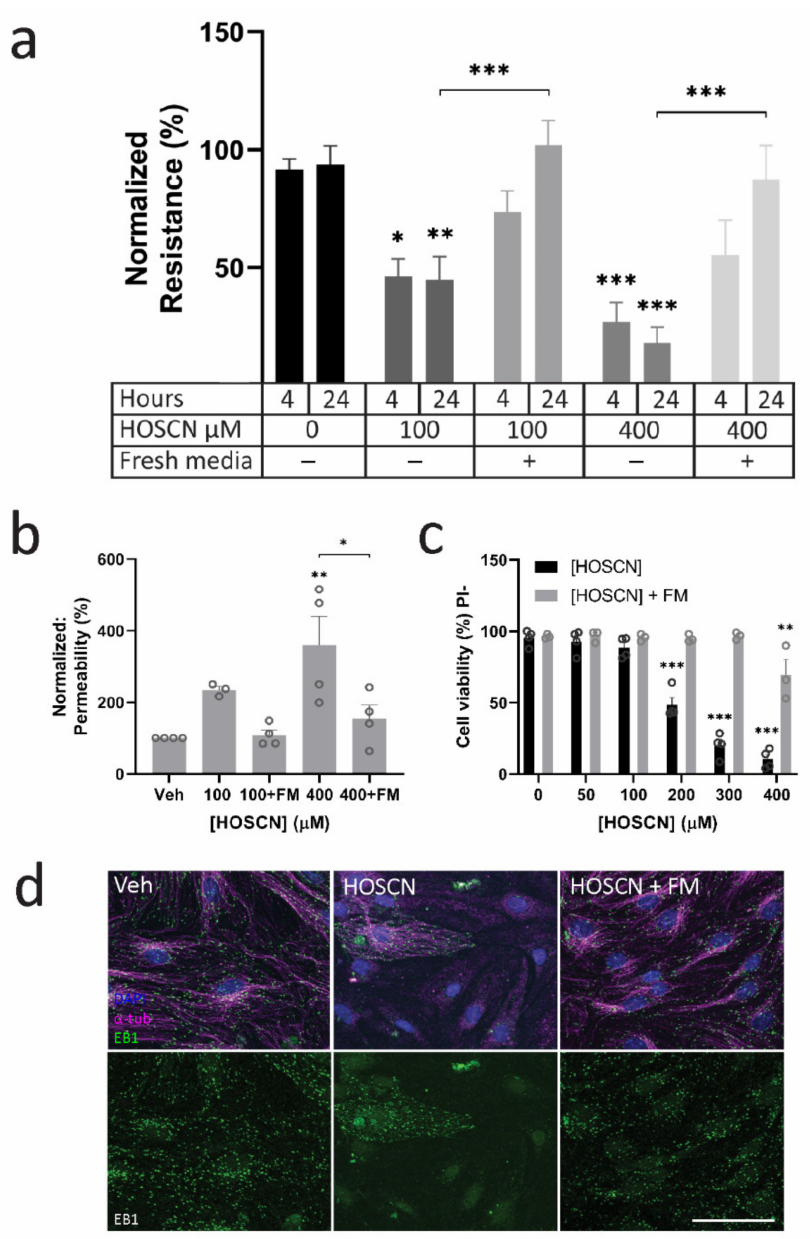
Figure 4. Short exposure of brain endothelial cells (BECs) to hypothiocyanous acid (HOSCN) does not impair endothelial barrier function. BECs were grown on transwells up to 14 DIV until an average barrier resistance of at least 100 Ω · cm 2 was reached. BECs were treated with HOSCN or vehicle for up to 24 h. Fresh media (FM) was given 30 min after HOSCN treatment. ( a ) Transendothelial